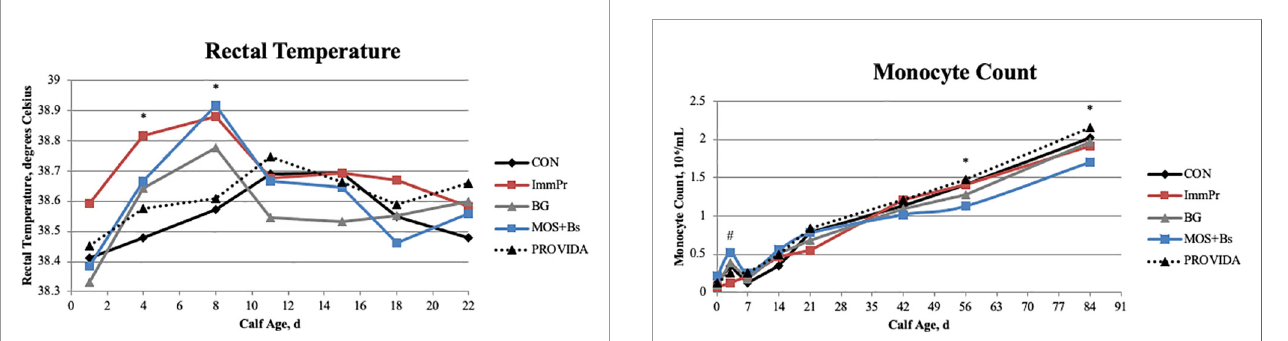
as degrees Celsius and include 0.096, 0.076, 0.080, 0.094, 0.072, 0.076, and 0.066 for d 1, 4, 8, 11, 15, 18, and 22, respectively. An * indicates a treatment difference of ( P ≤ 0.05) when treatments were sliced by